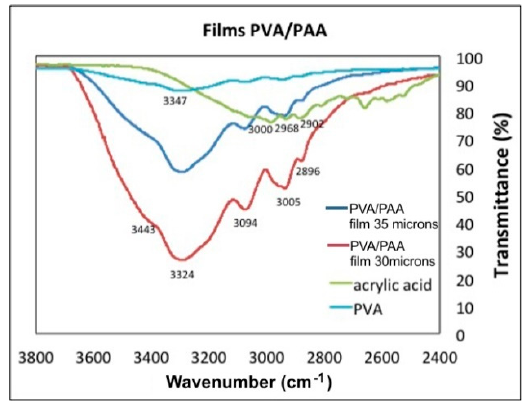
Figure 9. Transmittance as a function of Wavenumber for PVA, PAA, and two PVA/PAA films with different thickness.